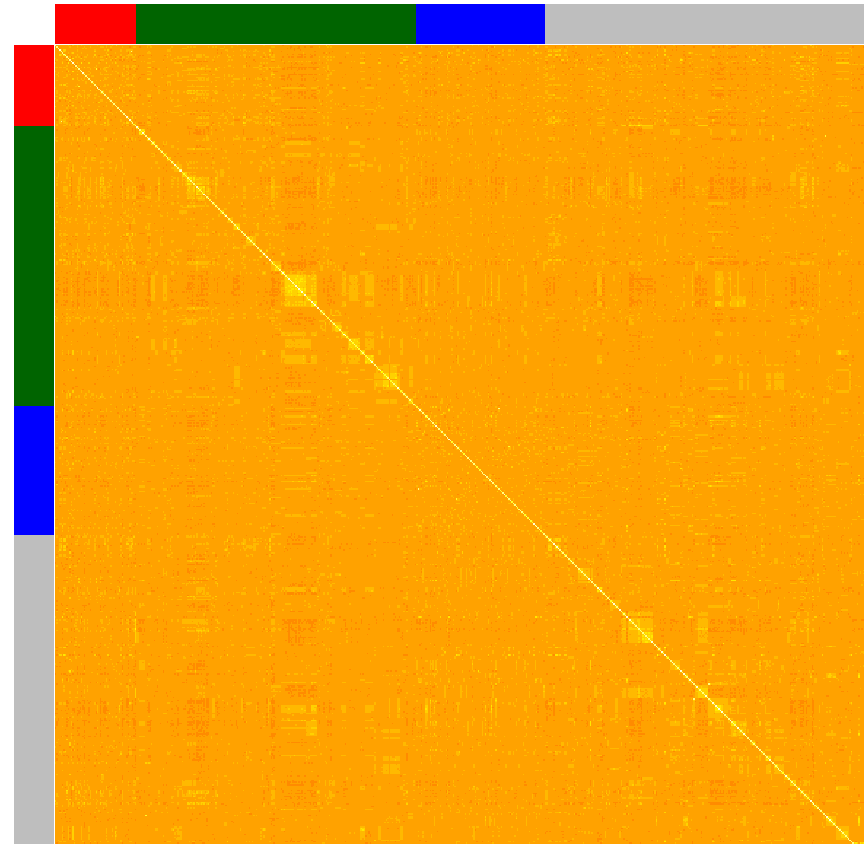
Figure 3. Heatmap of the Genomic Relationship Matrix (GRM). Lines belonging to the test panel are shown in red, lines from 2015 are shown in green, lines from 2016 are shown in blue, and lines from 2017 are shown in